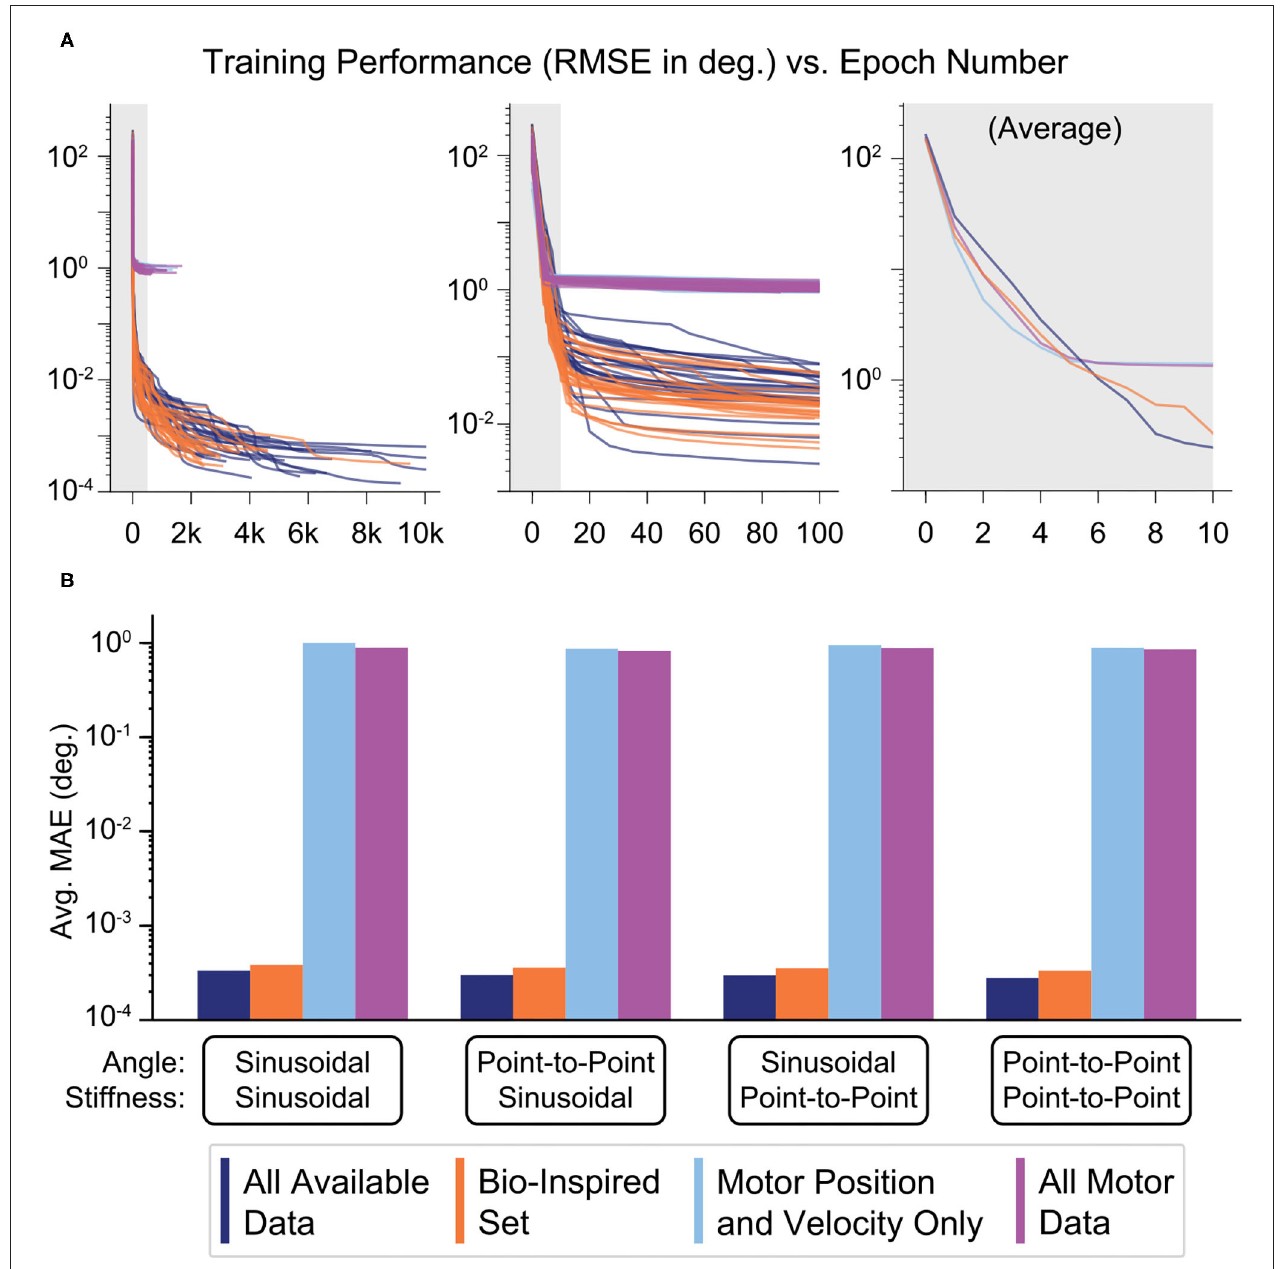
FIGURE 9 | (A) Performance (RMSE in degrees) vs. the number of epochs needed to train each ANN. For each of the four sensory sets, 25 motor babbling simulation of 15 s were performed to train ANNs with 15 hidden-layer nodes. Although it took the ANNs more than 1,000 epochs for the performances to converge (even requiring up to 10,000 epochs for the ANNs trained with tendon tension data), the majority of the performance improvement came within the first 20–50 epochs ( middle ). In fact, the ANNs trained only with motor data ( Motor Position and Velocity Only and All Motor Data ) converged with as little as 6 epochs (as seen by the average plot on the right ). Lastly, it appears that learning from motor information may have allowed for faster learning, but the performance was soon beaten by the ANNs trained with tendon tension (which took longer to learn). (B) Bar plots of the average performance (MAE) of each of the four ANNs when predicting joint angle from the four generalization movements (plotted on a log scale. For each sensory set, there is little difference across movements, but there is a consistent trend that the sensory sets that include tendon tension ( All Available Data and the Bio-Inspired Set ) perform 3 orders of magnitude better than the sets trained without tendon